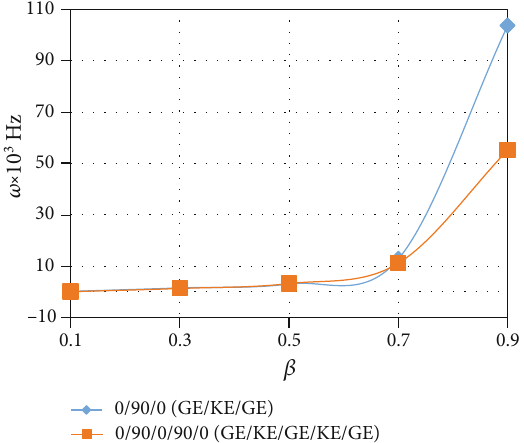
Figure 6: Variation of angular frequency and radius ratio of 3- and 5-layered annular circular plates. S-S.